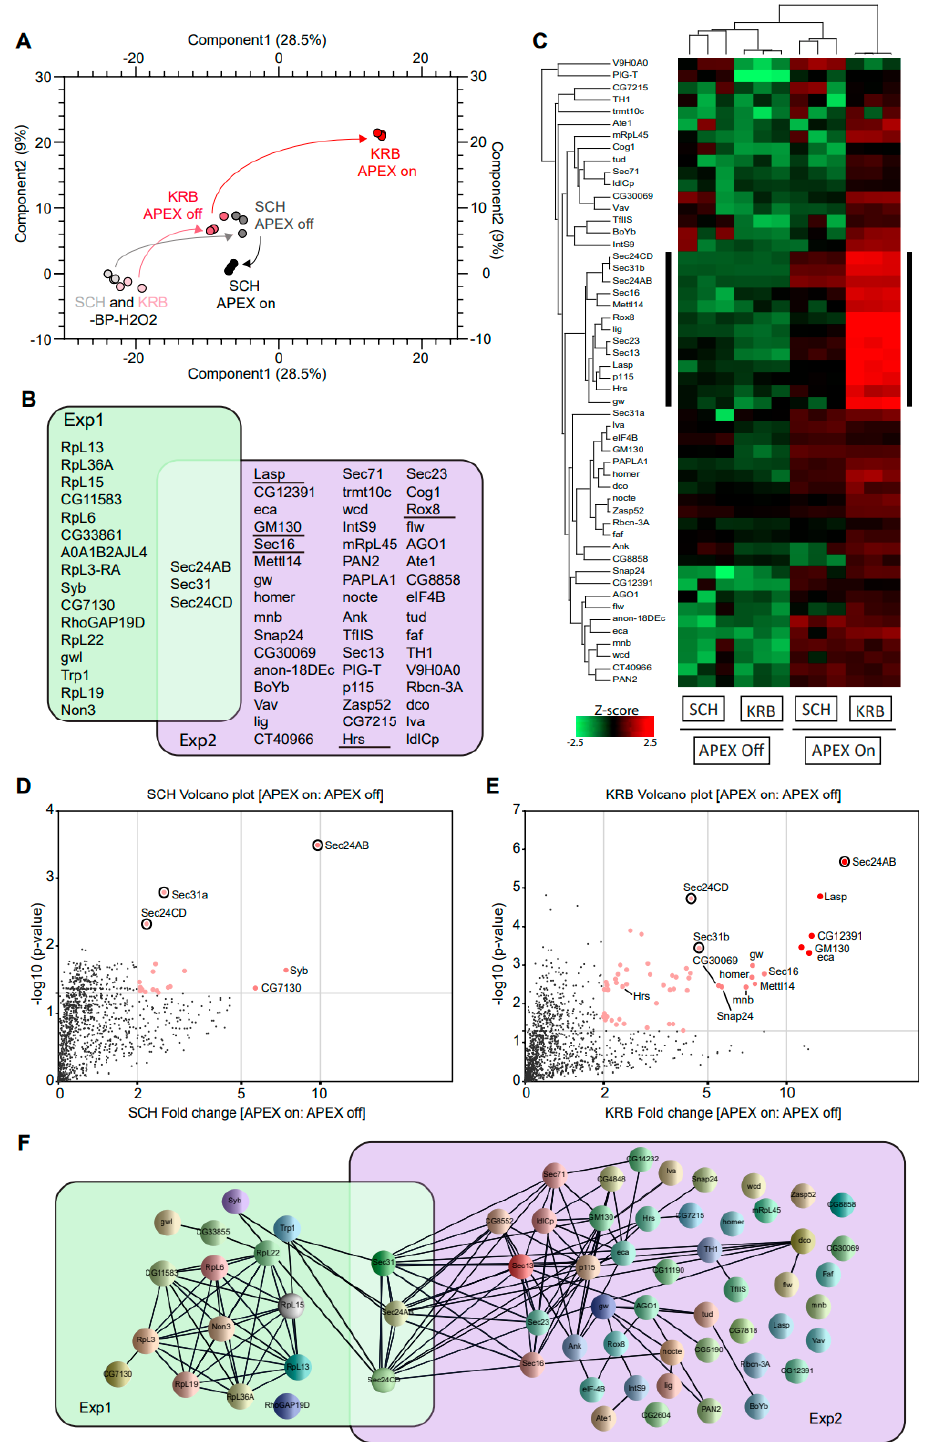
Figure 2. Sec24-APEX2 mediates the biotinylation of Sec body proteins. ( A ) Principal component analysis (PCA) depicting the impact of BP addition and H 2 O 2 APEX activation. In -BP-H 2 O 2 conditions, APEX labeling in SCH and KRB have a similarly low background (light grey and light pink, respectively). In +BP-H 2 O 2 conditions, APEX labeling in SCH and KRB remain similar (dark grey and dark pink, respectively). Differential proximity biotinylation in Sec bodies (red) depends largely on H 2 O 2 . ( B ) Overlap of proteins biotinylated in the vicinity of Sec24. Sec24 has a largely distinct protein interactome during growing (green) and starvation (purple) conditions.